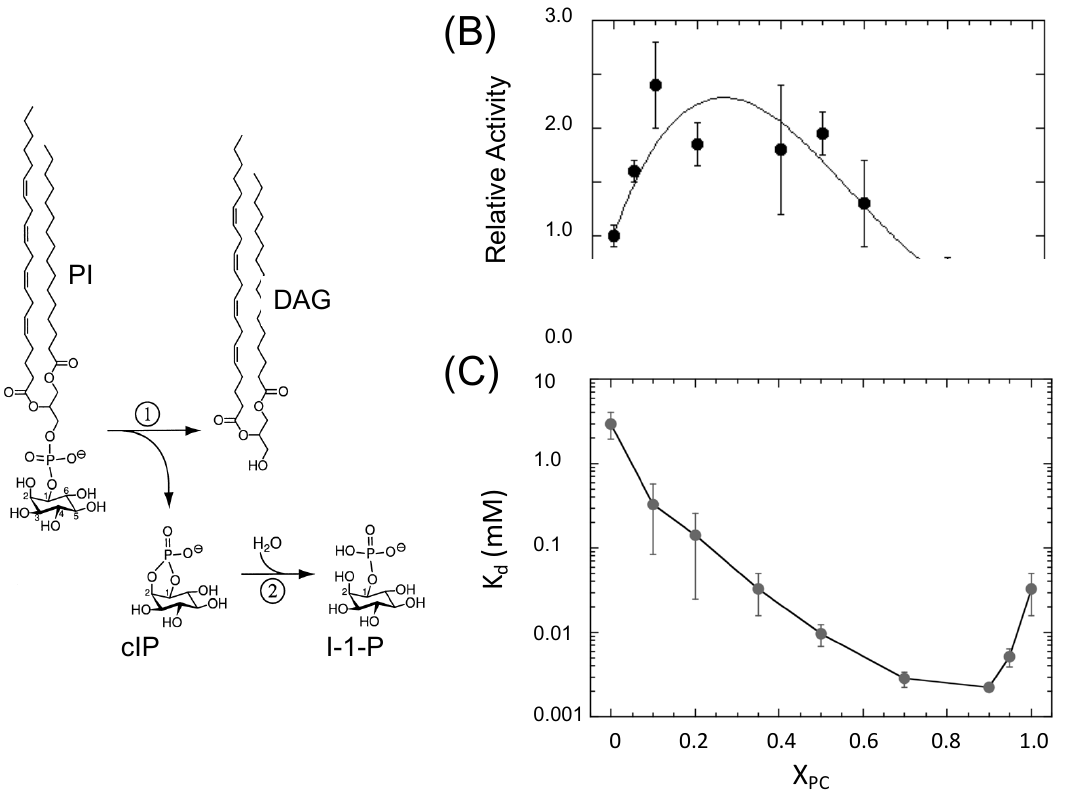
Figure 1. Bt PI-PLC chemical reaction and the effect of POPC on enzymatic activity and apparent dissociation constants. ( A ) Reaction catalyzed by PI-PLC produces DAG and cIP, the latter being a stable intermediate eventually hydrolyzed to I-1-P. ( B ) Enzyme activity towards PI in SUVs with POPC is shown as a function of mole fraction PC, X PC , under conditions where >75% of the enzyme is bound to vesicles. ( C ) Binding of PI-PLC to DOPG/POPC bilayers as a function of X PC . Graphs ( B , C ) are adapted with permission from Biochemistry 2009, 48, 6835–6845. Copyright (2009) American Chemical Society.